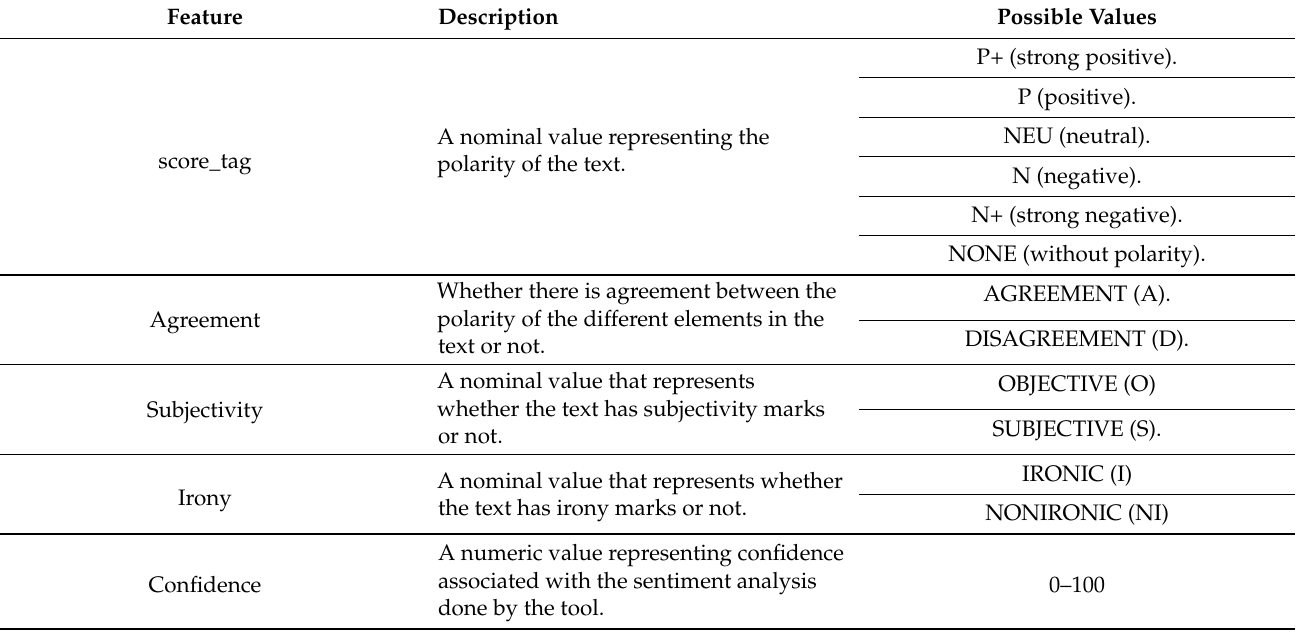
Table 6. Features extracted from